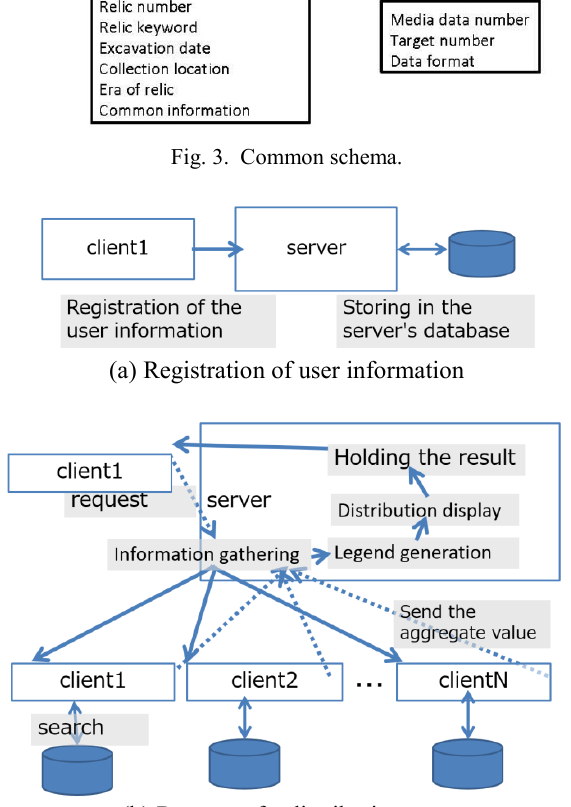
Fig. 3. Common schema.